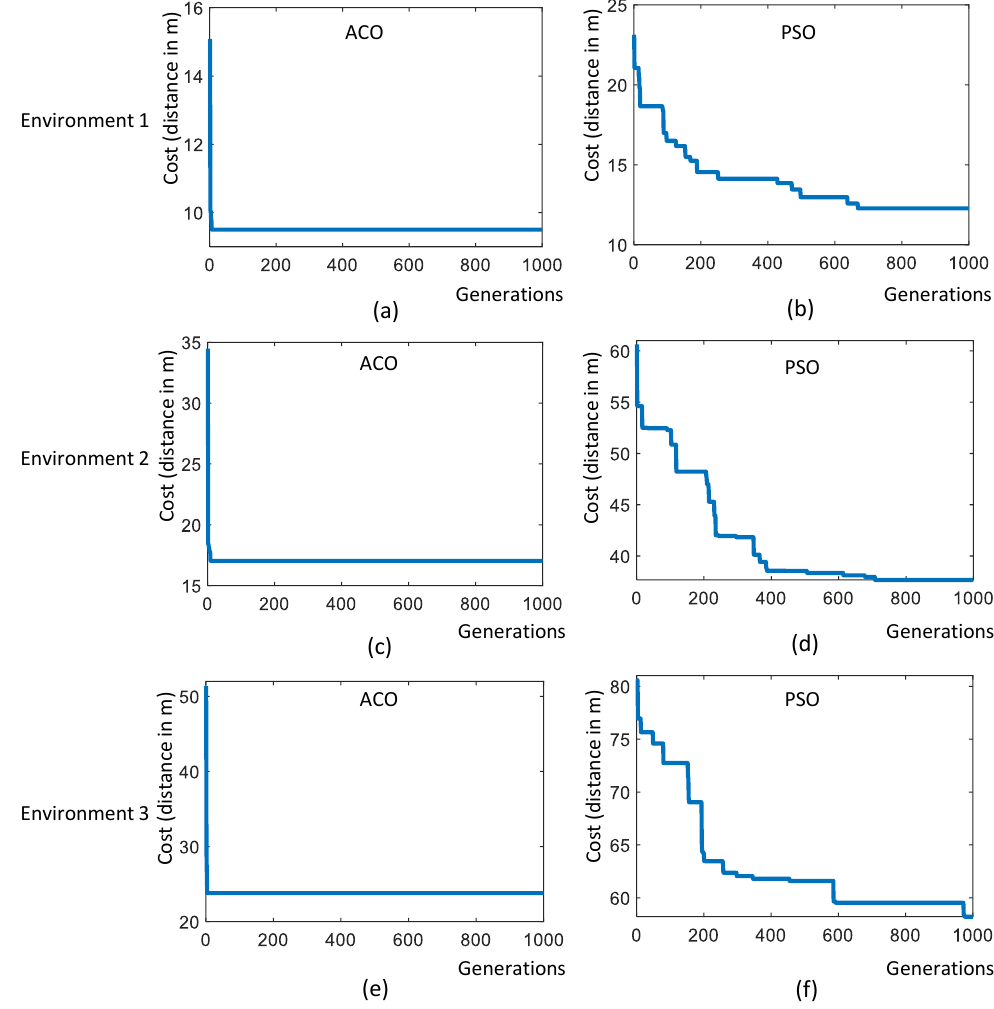
Figure 11. Convergence results of ACO and PSO. ( a ): Environment 1 using ACO, ( b ): Environment 1 using PSO, ( c ): Environment 2 using ACO, ( d ): Environment 2 using PSO, ( e ): Environment 3 using ACO, and ( f ): Environment 3 using